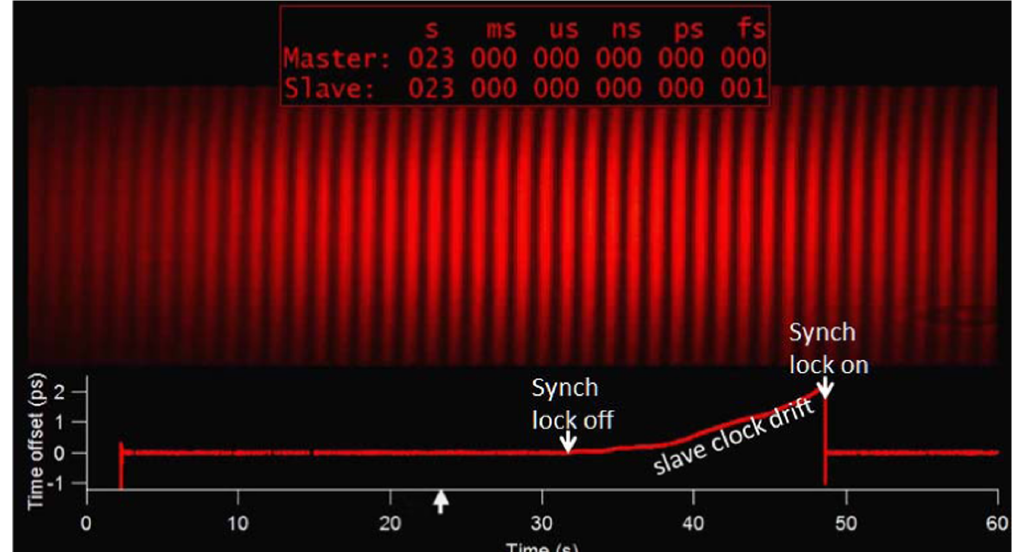
VIDEO 1. Video demonstrating synchronous optical PPS outputs. (See also Fig. 8.) The video shows the strong interference during synchronization and the lack of an interference pattern when clock B is free-running. The strong interference during synchronization verifies that the pulses arrive well within their correlation time of ∼ 300